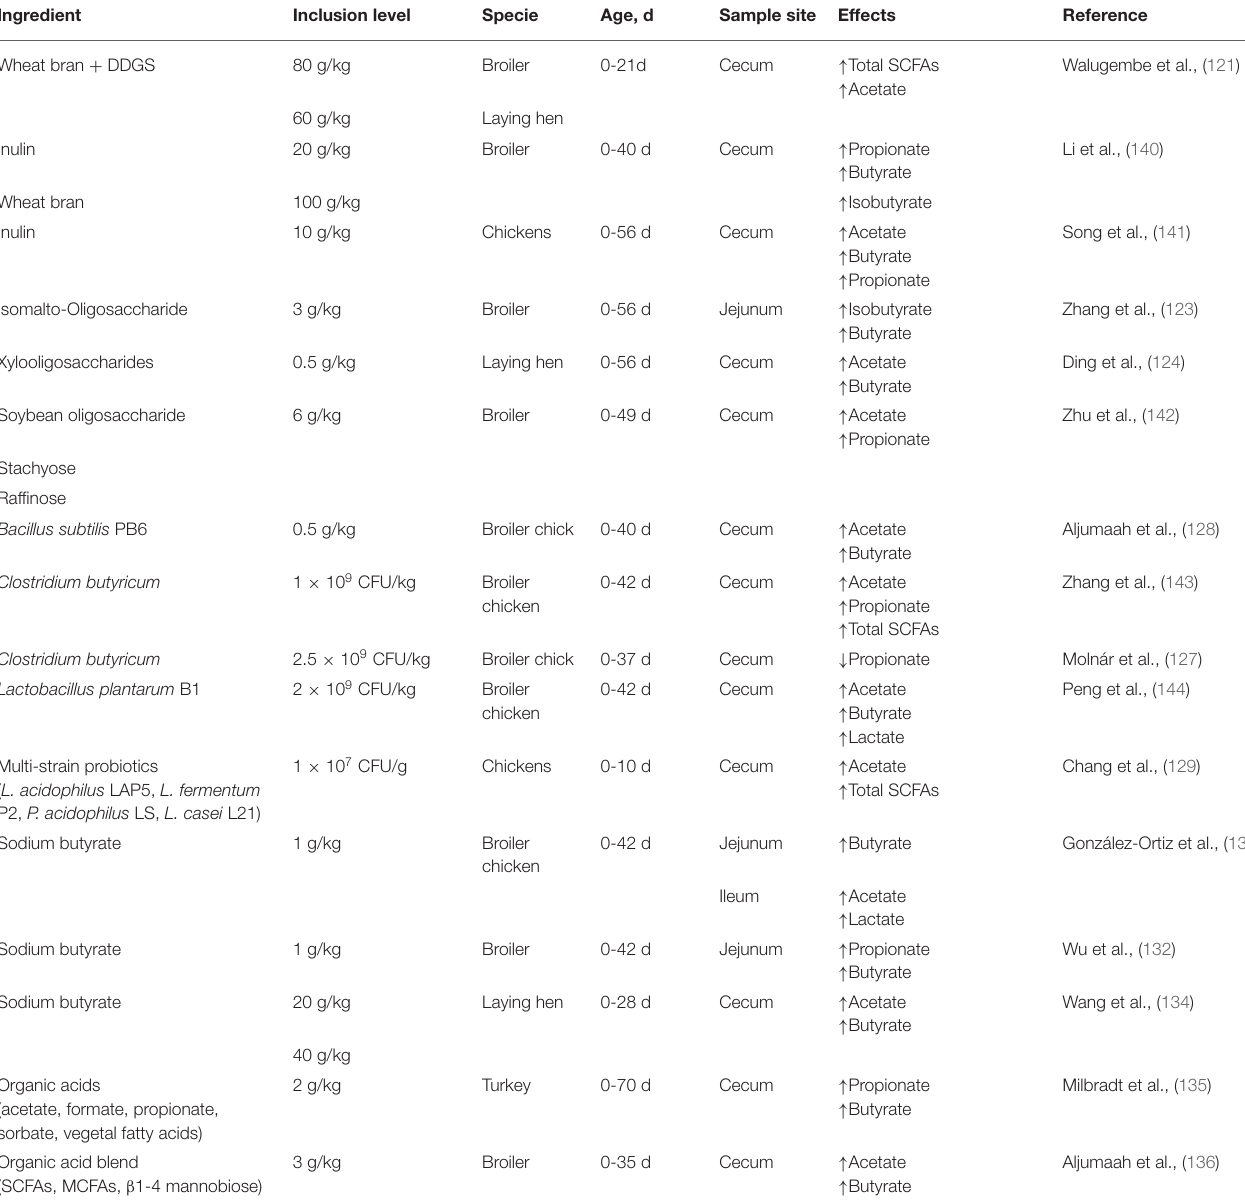
TABLE 1 | Effects of dietary fiber, prebiotics, probiotics and additives on SCFAs production. Ingredient Inclusion